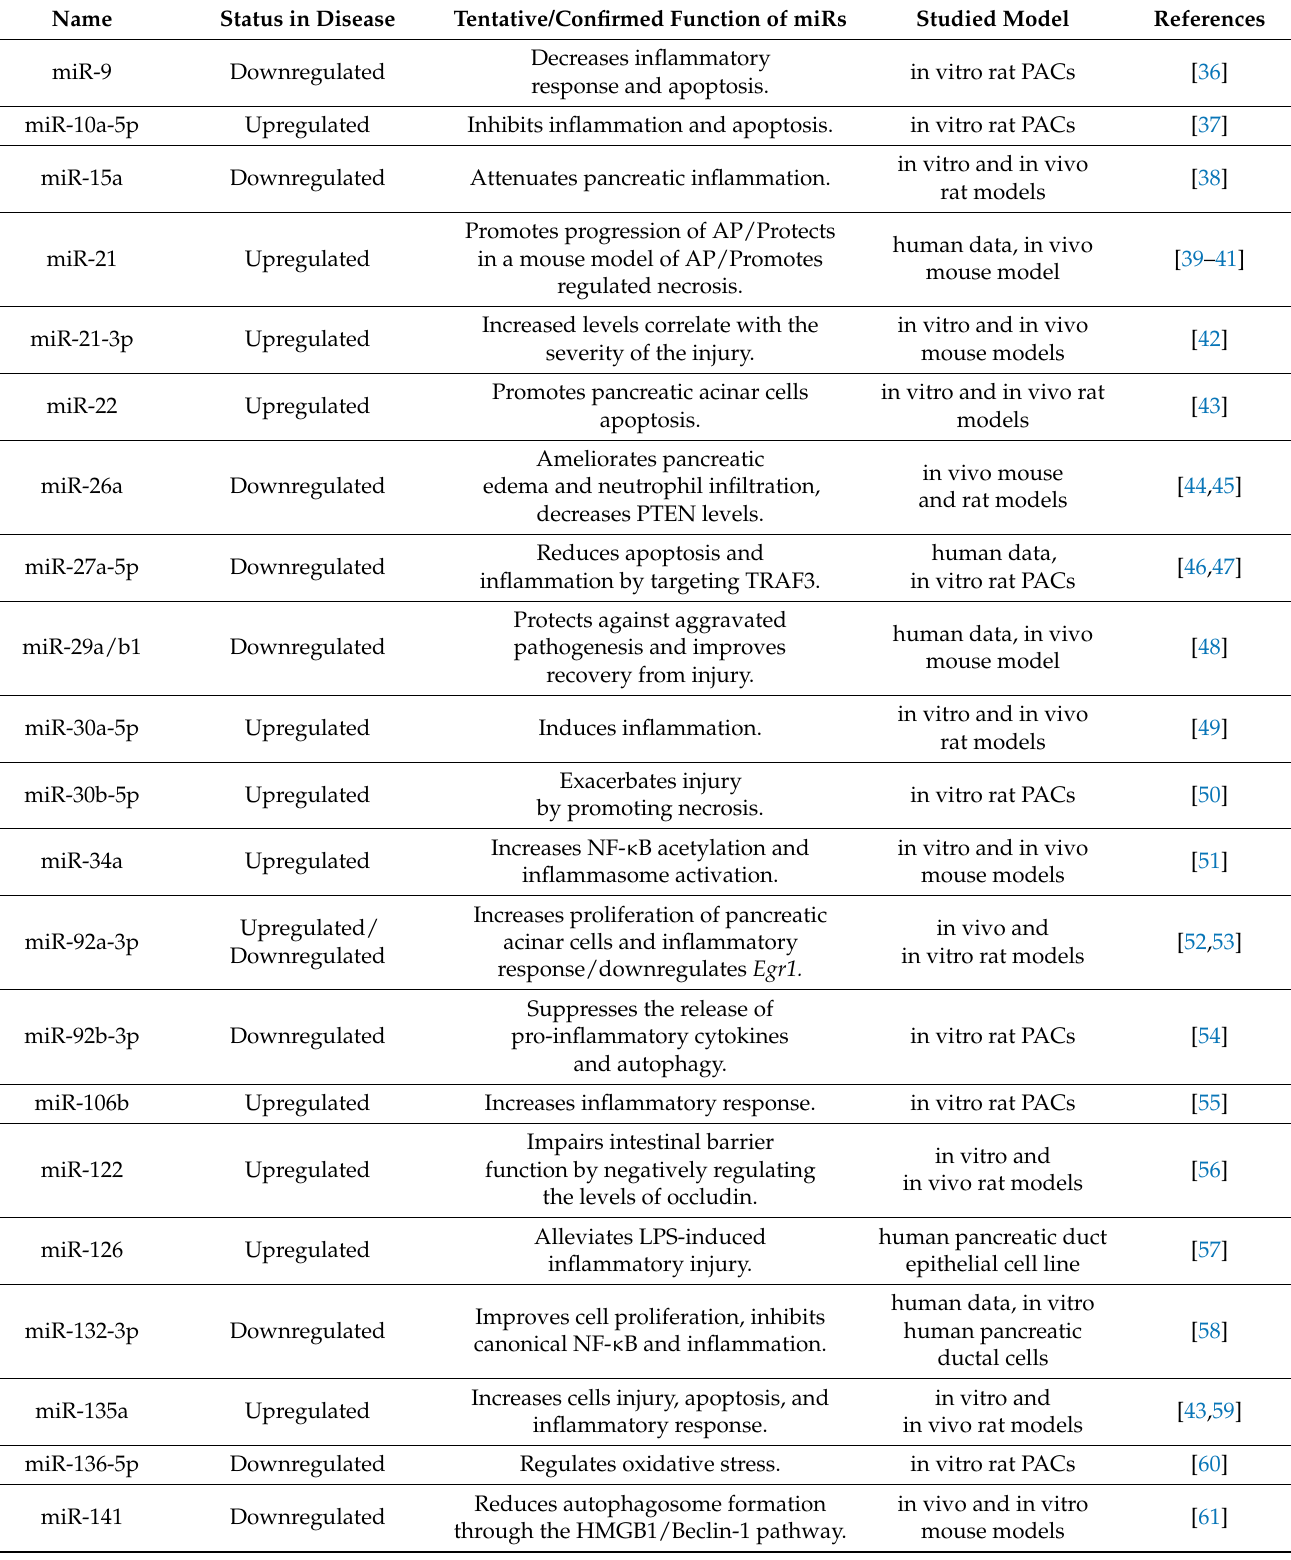
Table 1. Table summarizing the role of miRs in acute